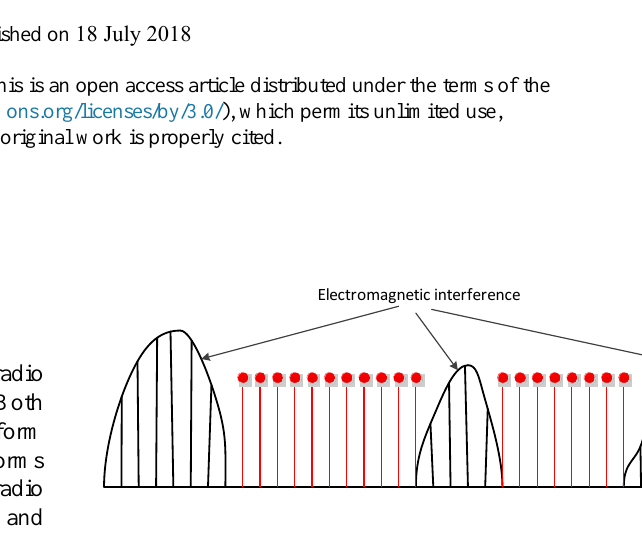
Figure 1. NC-OFDM/TDCS energy